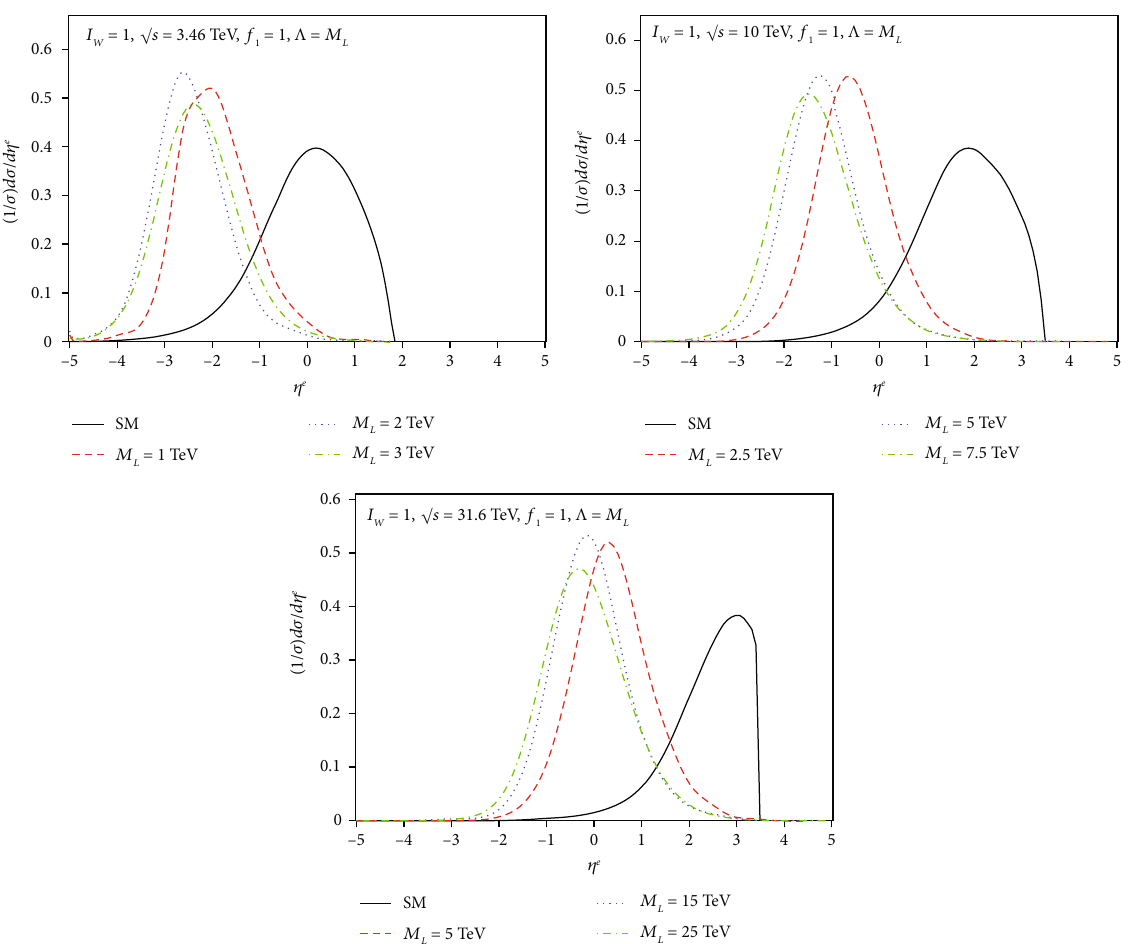
Figure 6: Normalized η distribution of the fi nal-state electron for the I